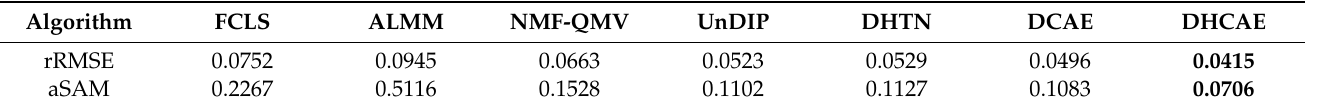
proaches. The best result is shown in